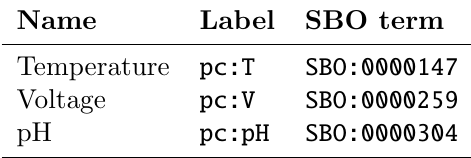
Table 2.5: A sample of values from the physical characteristics vocabulary (Section